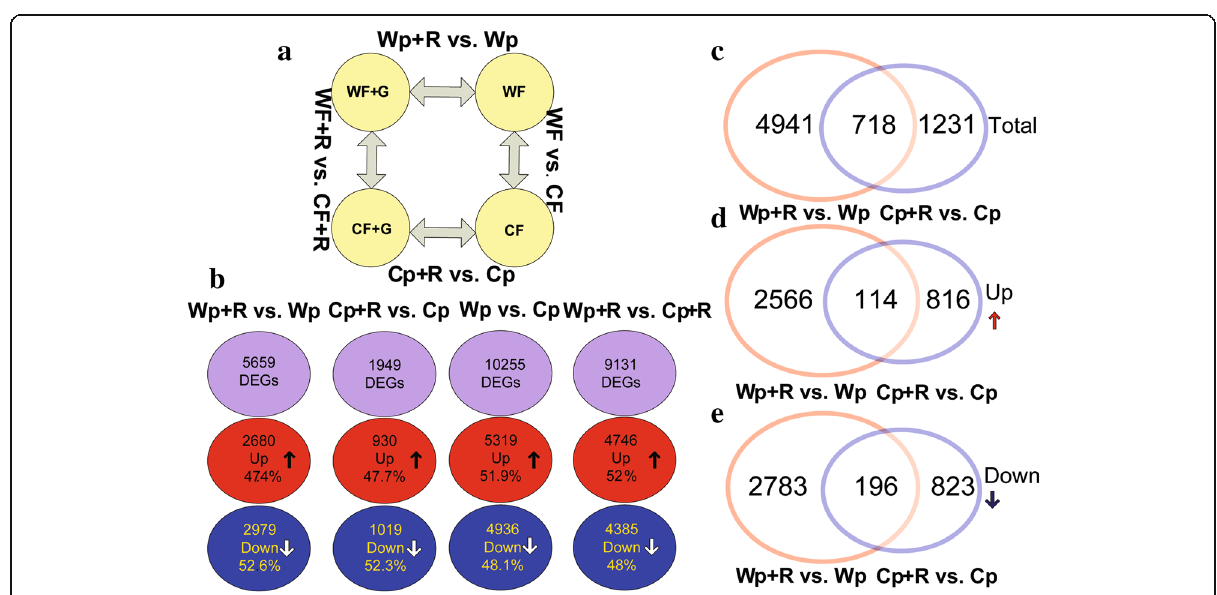
Fig. 4 Numbers of differentially expressed genes (DEGs). a Diagram illustrating the experimental design and comparisons. b Diagram illustrating the number of total, up-regulated, and down-regulated genes in the four comparisons. c , d , and e . A Venn analysis of the number of total, up- regulated, and down-regulated DEGs identified in the ‘ Wp+R vs. Wp ’ and ‘ Cp+R vs. Cp ’ comparisons. Cp + R, Rhizoglomus intraradices -inoculated cultivated rice infected with Magnaporthe oryzae ; Cp, R. intraradices -uninoculated cultivated rice infected with M. oryzae ; Wp + R, R. intraradices - inoculated wild rice infected with M. oryzae ; Wp, R. intraradices -uninoculated wild rice infected with M.